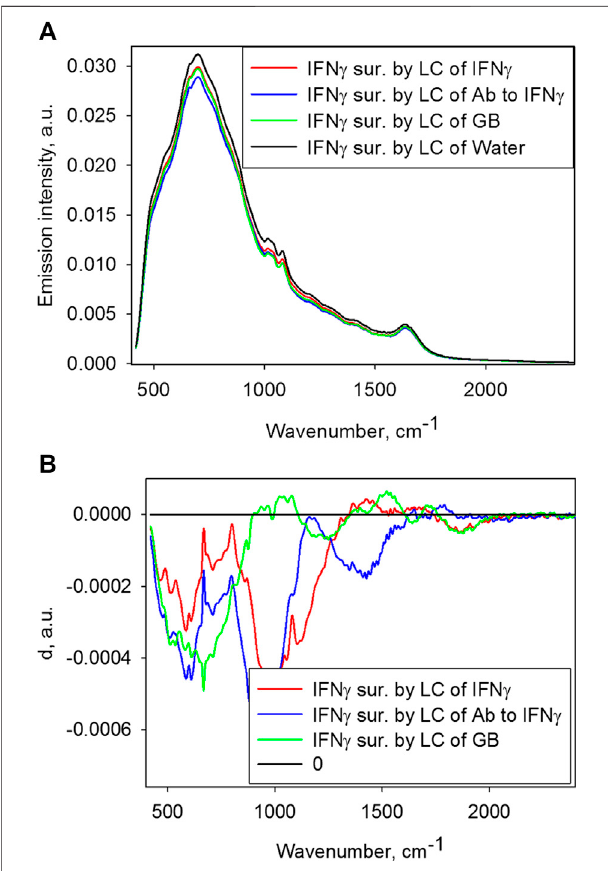
FIGURE 4 | (A) Emission spectra of the IFN γ 1 mg/ml solutions surrounded by each test sample and the control. (B) Paired comparisons of emission spectra of the IFN γ 1 mg/ml solutions surrounded by the test samples and the control for detecting statistically signi fi cant differences according to formula